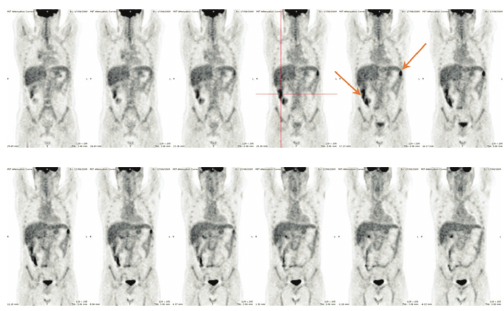
Figure 1: Example of a true positive patient: 18 F-FDG PET/CT performed 25 days after allo-SCT in a 46-year-old patient who presented with signs of acute GI-GvHD 30 days after